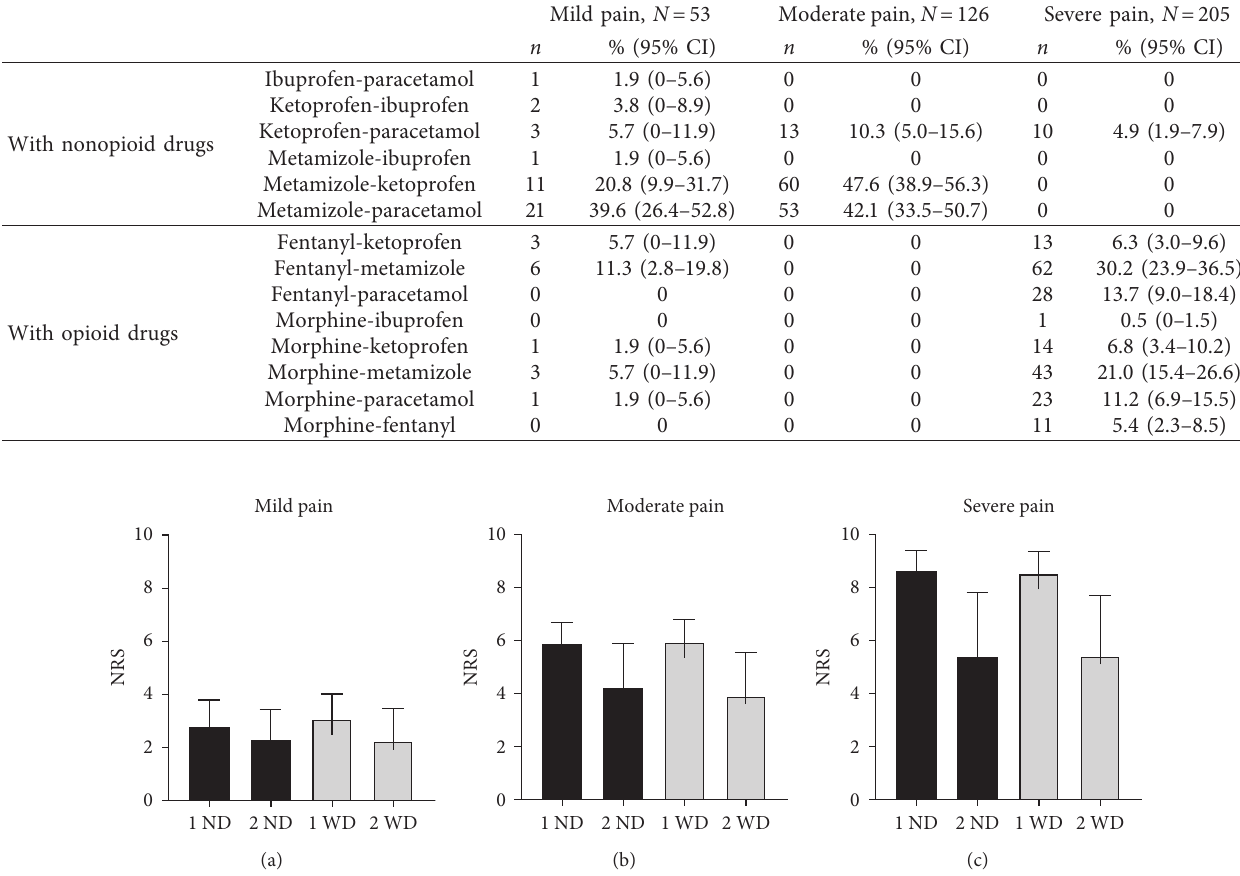
Figure 3: Pain severity in patients with mild (a), moderate (b), and severe (c) pain who did not receive (no-drugs group, ND) analgesic drugs (in the first and second assessments: 1ND, 2ND) and patients who received the drug (with-drugs group, WD; in the first and second assessments: 1WD, 2WD